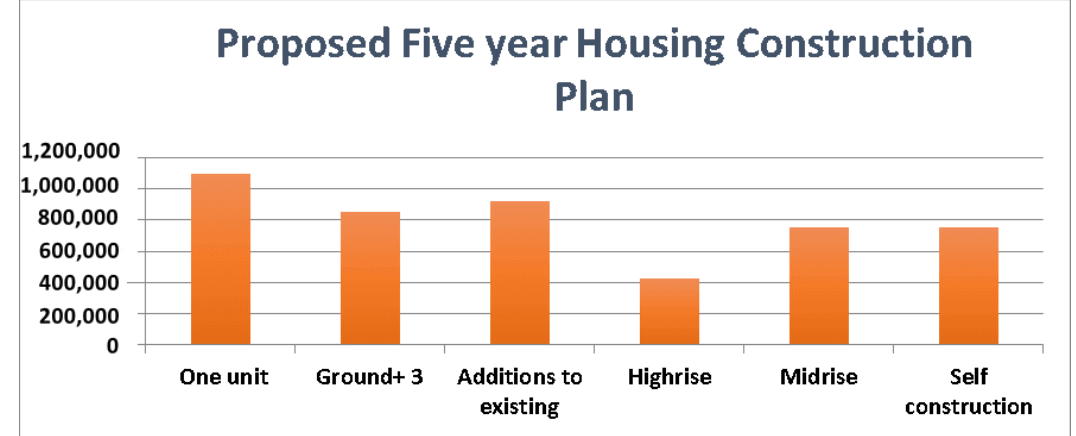
Figure 2. Pakistan Tehreek-e-Insaf (PTI)’s housing plan (Naya Pakistan Housing Scheme 2020 [45]) . (h) Orangi Pilot Project (OPP): it is a non-governmental organization (NGO) established in Karachi